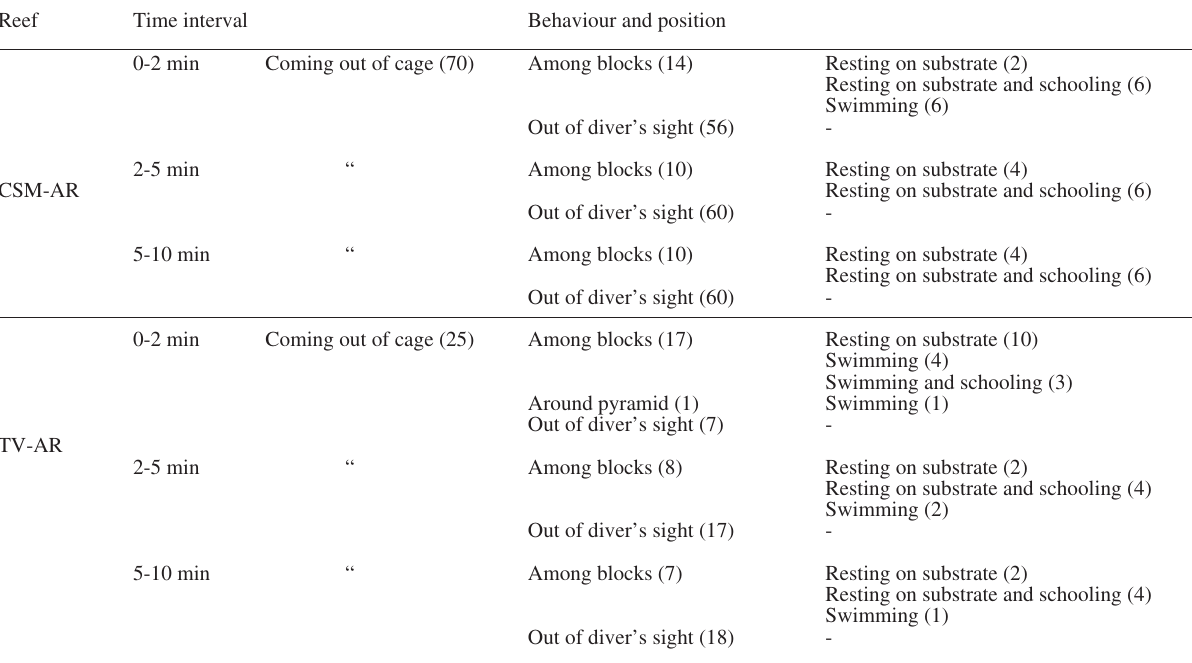
Table 4. – Behaviour and position of the dusky groupers released at the artificial reefs of Capo S. Marco (CSM-AR) (N=70) and Torre Verdu- ra (TV-AR) (N=25) at different time intervals (0-2, 2-5 and 5-10 min.) after the cages were opened. Numbers of groupers are in parenthesis.